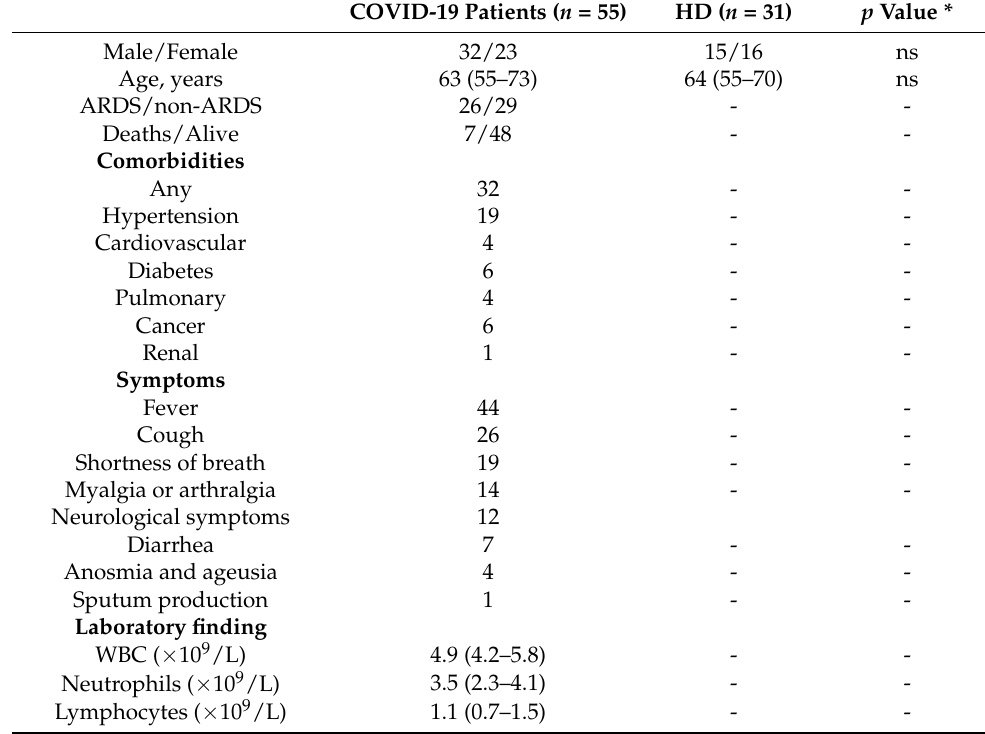
Table 1. Demographic and clinical features in COVID-19